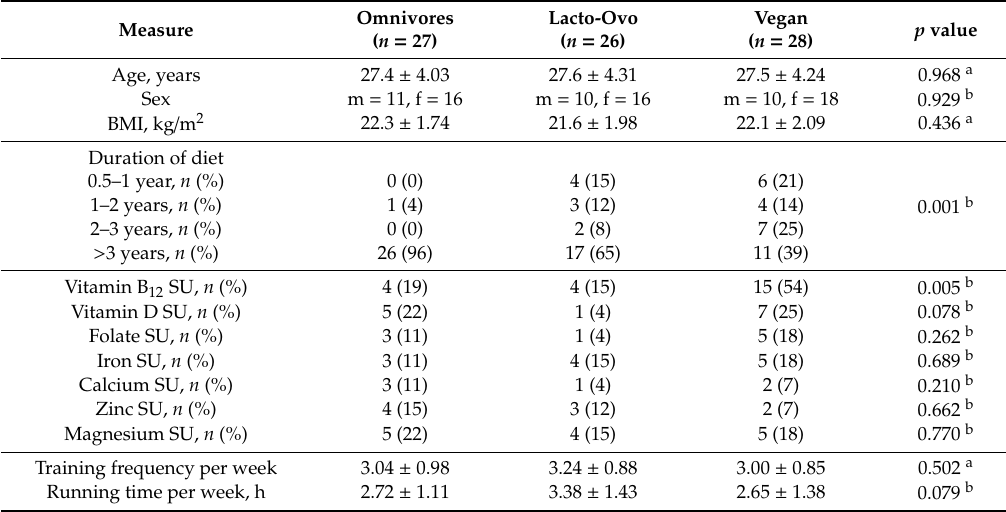
Table 1. Participant characteristics by dietary patterns of the study